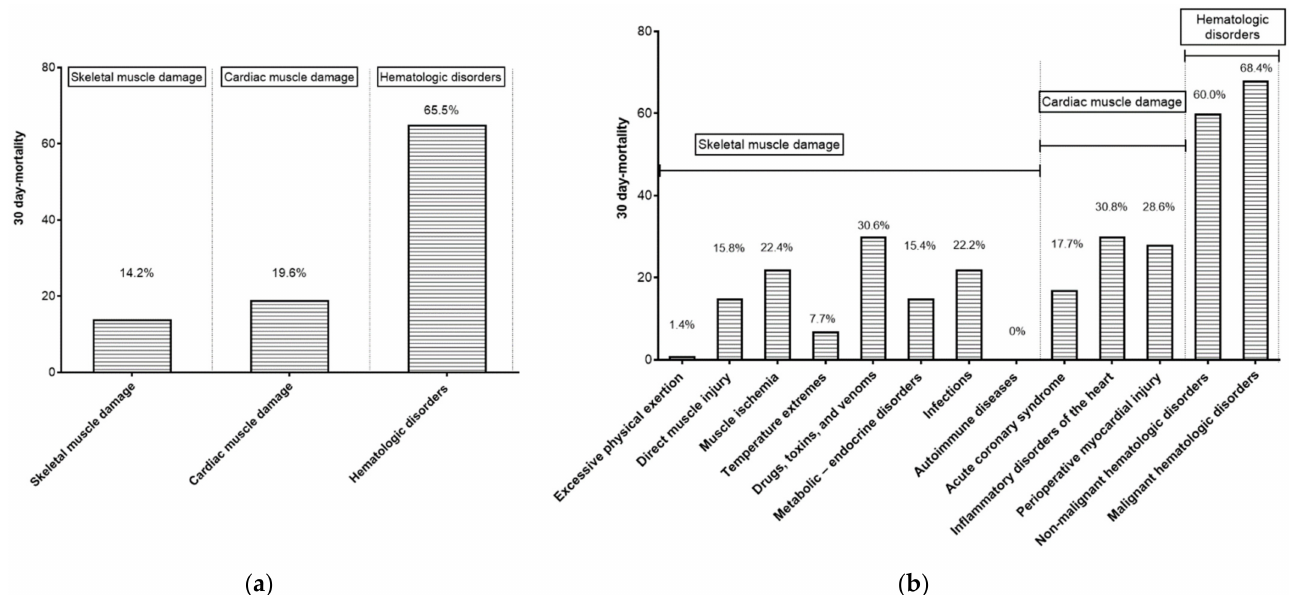
Figure 2. Thirty-day mortality rates of the 3 etiologic groups ( a ) and 13 subdivided categories ( b